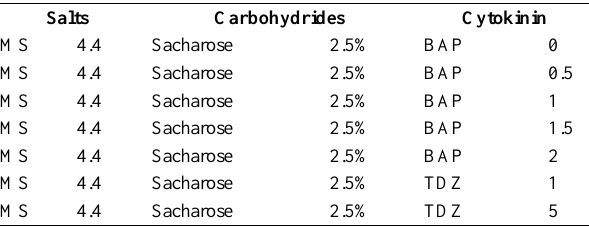
Table 1. The regeneration media for O. basilicum L. in vitro